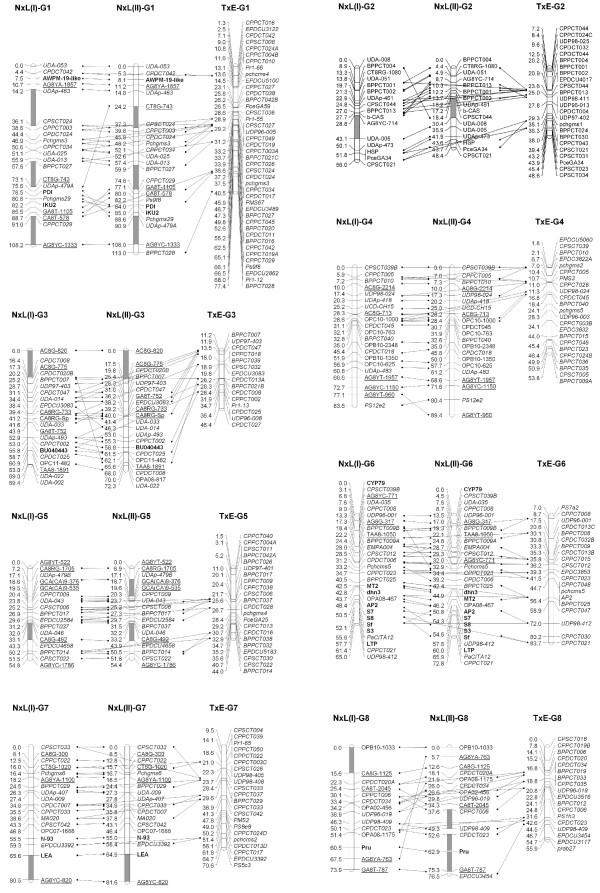
The alignment of the linkage groups between maps of the cross 'Nonpareil' × 'Lauranne' (N × L) F1 population constructed using One-step and Two-step methods, and with the Prunus T × E reference map that include only SSR markers. The maps of N × L population were constructed using the JoinMap® 3, and the maps were viewed and aligned by the MapChart 2.2. The SSR markers are shown in italics, the SNP-anchored genes and S-loci are in bold, ISSR markers are underlined, and the RAPD markers are in plain font. The genetic distance of the loci are shown in centimorgans (cM) and the gaps between two adjacent markers > 10 cM are highlighted in grey segments on the linkage group bars.